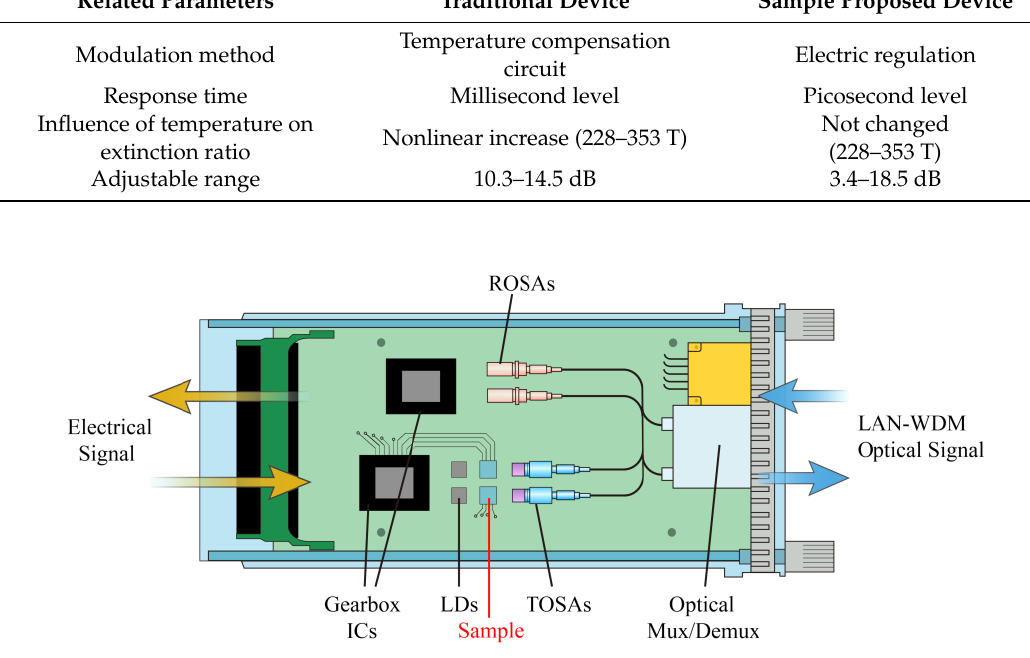
Figure 8. Application of extinction ratio regulation of devices in an optical module.